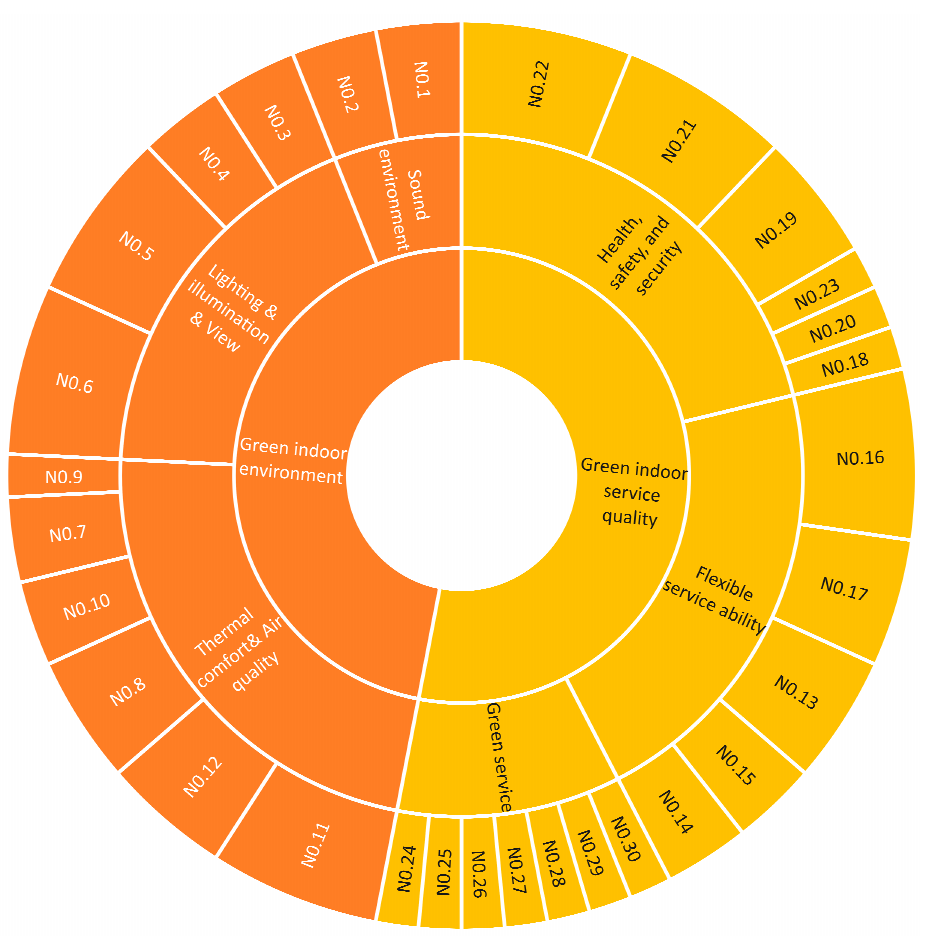
Figure 6. The evaluation model.